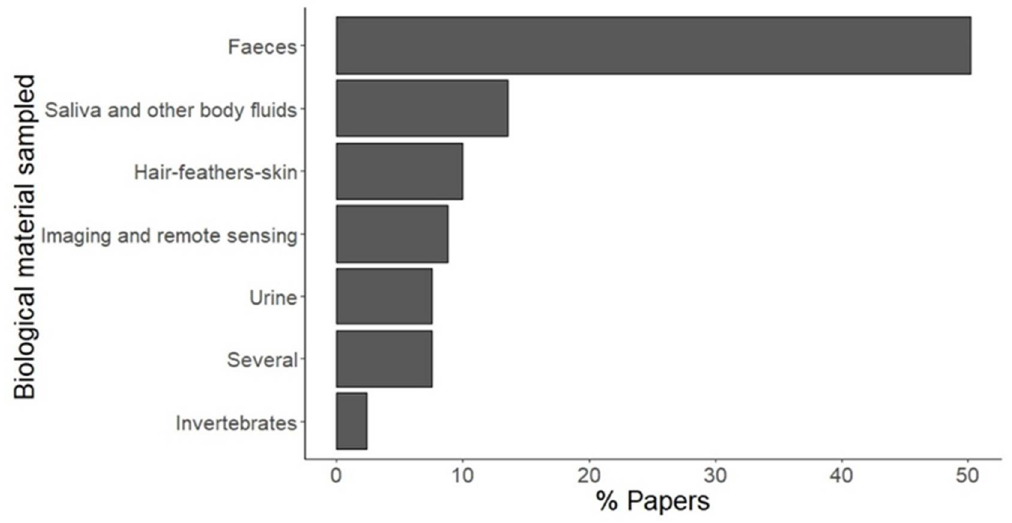
Figure 3. Th percentage of published articles by collected material. For a definition of categories, see Table 1.